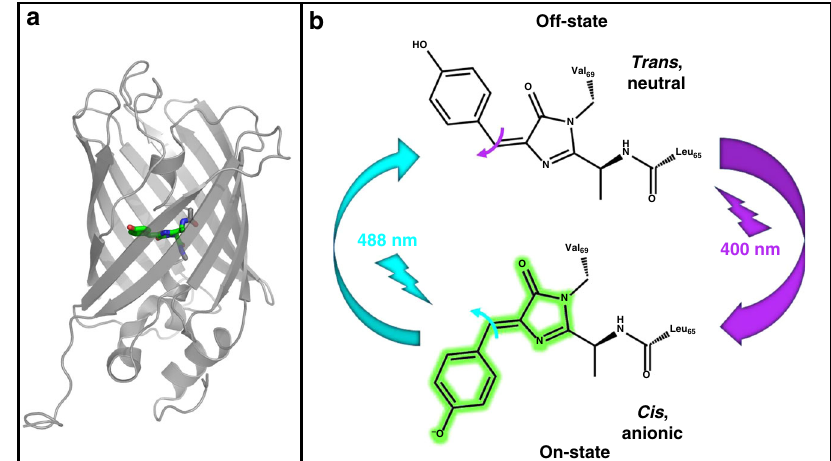
Fig. 1 Structure and photoswitching scheme of rsEGFP2. a Three-dimensional structure showing an 11-stranded β -barrel embedding a chromophore held by a central α -helix. b The chromophore of rsEGFP2 in its fl uorescent on-state (bottom) absorbs at 479 nm (laser 488 nm) and emits at 503 nm. Isomerization competes with fl uorescence and leads the chromophore to its non- fl uorescent off-state, which absorbs at 403 nm (laser 400 nm) and ultimately isomerizes back to the initial on-state. Flashes and arrows represent the color of each actinic wavelength. The width of arrows is representative of the ef fi ciency of each